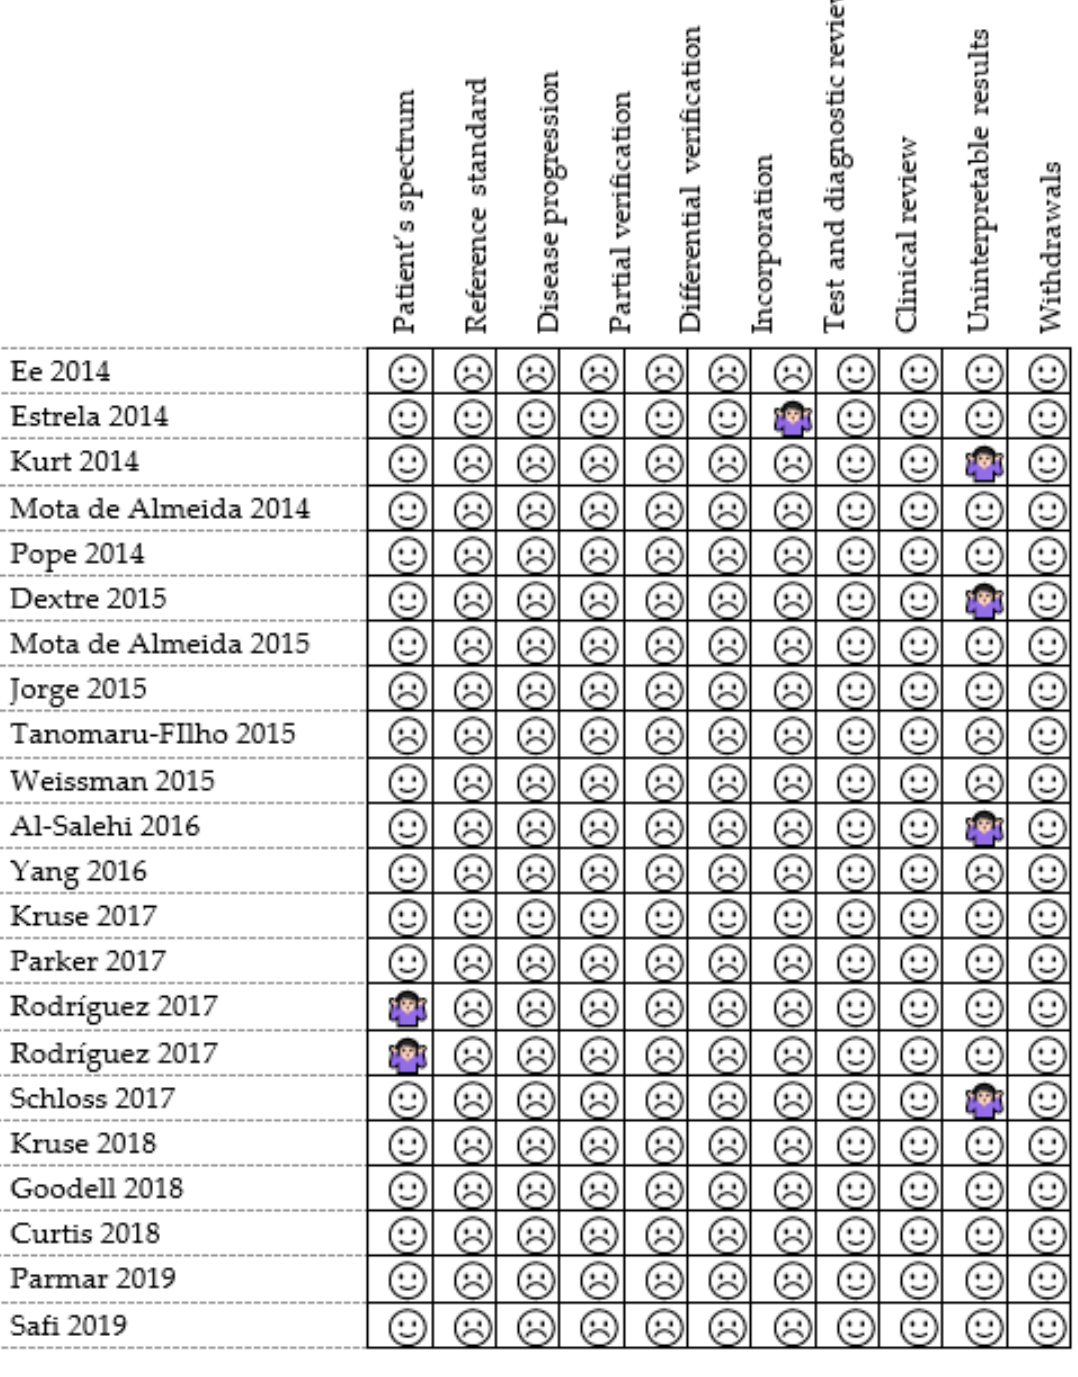
Figure 2. Risk of bias of the included studies: 🙂 —adequate, ☹ —inadequate, (cid:4879) —unclear.